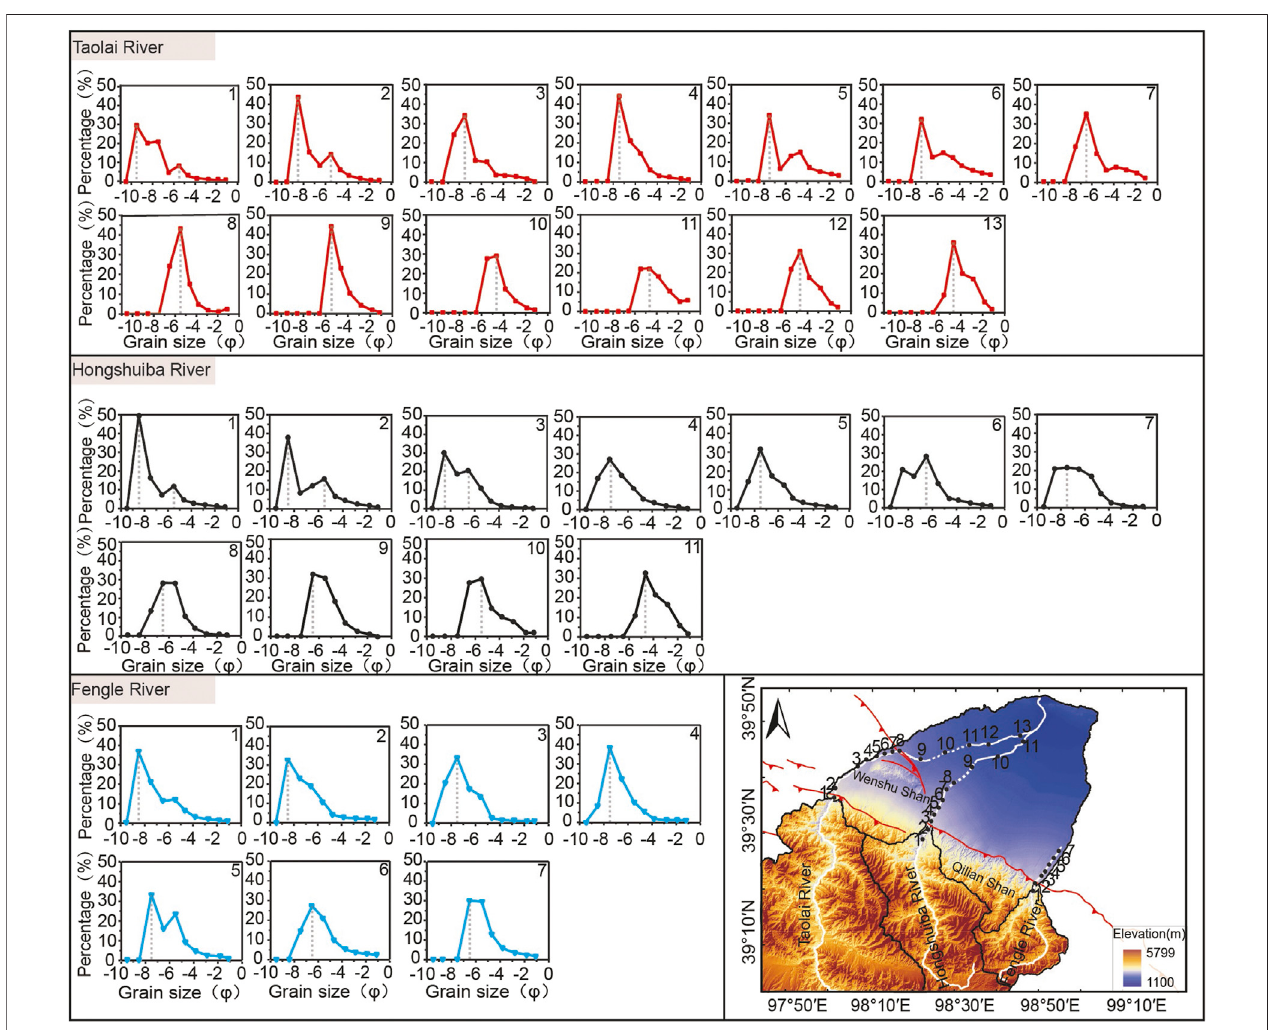
FIGURE 6 | Grain-size frequency distribution curves of bedload gravel along the Taolai, Hongshuiba, and Fengle Rivers. The sampling sites are numbered in downstream sequence and in correspondence with the inset map.